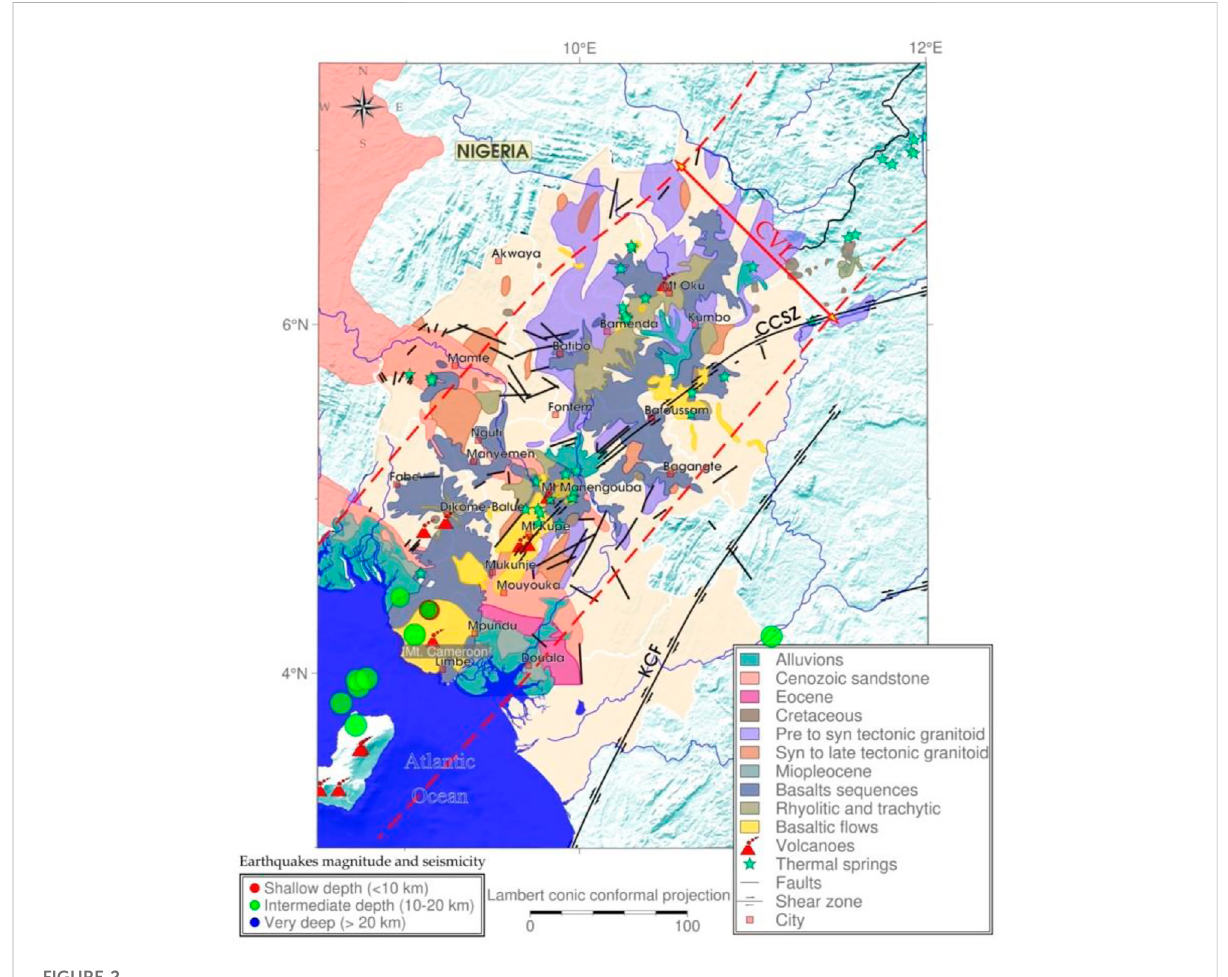
FIGURE 2 Geology map of Southern Cameroon (after Ghomsi et al.,